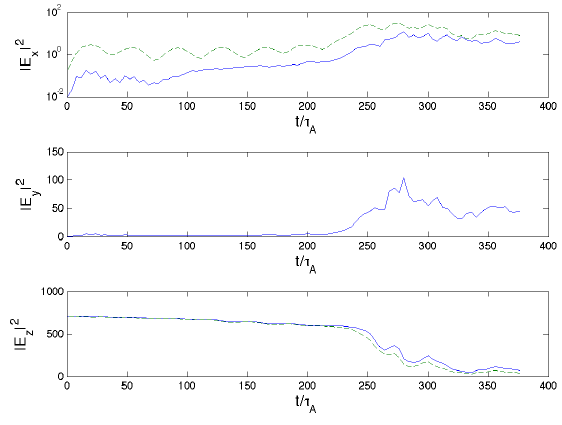
Fig. 8. History of the electric field energy for a run with the initial force-free reversed field equilibrium and with S = 10 4 and R v = 10 4 . The electrostatic component is shown as a dashed line, the total as a solid line. Note that in a 2-D simulation in the (x,z) plane only the two in-plane components can be present for the electrostatic field.